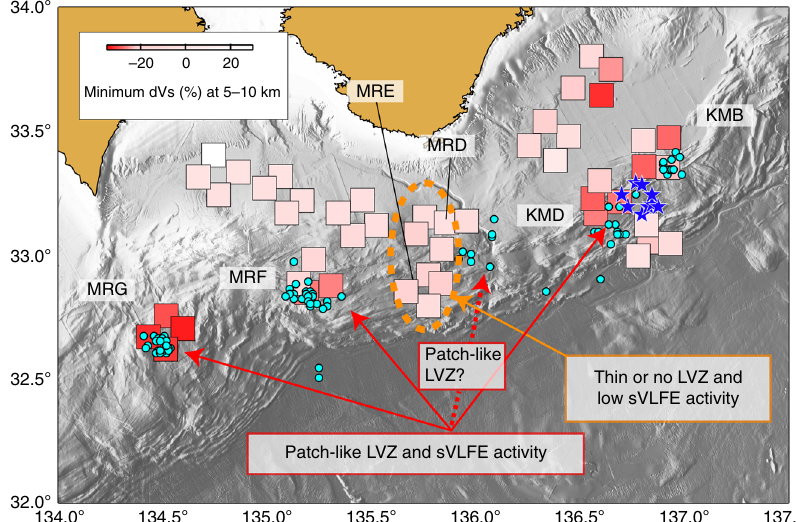
Fig. 3 Spatial relationship between LVZ and sVLFE determined by sea fl oor records. The intensity of red in the squares indicates the minimum dVs in the depth range of 5 – 10 kmbsl. Locations of squares correspond to station locations. Pale blue circles 29 and blue stars 23 show epicentres of sVLFEs determined from sea fl oor records